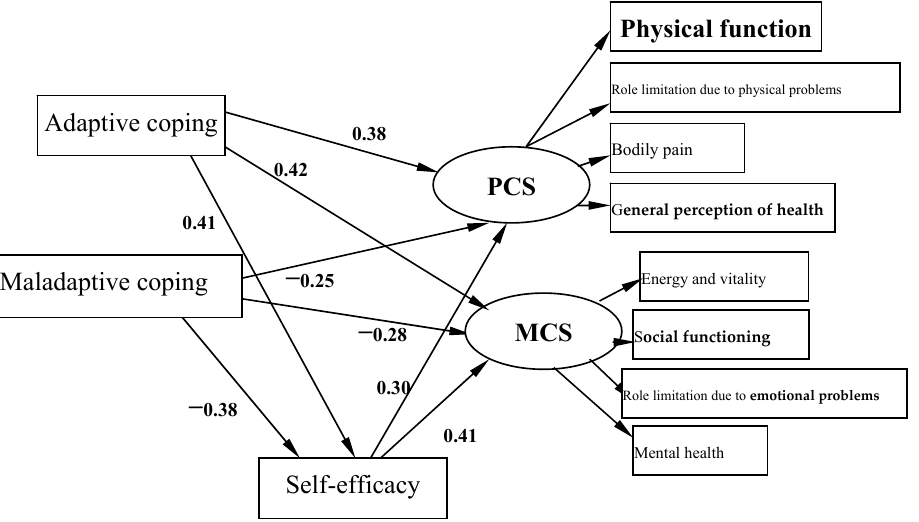
Figure 2. Structural equation modeling of mediating role of self-efficacy on the association between coping and QOL (PCS and MCS).